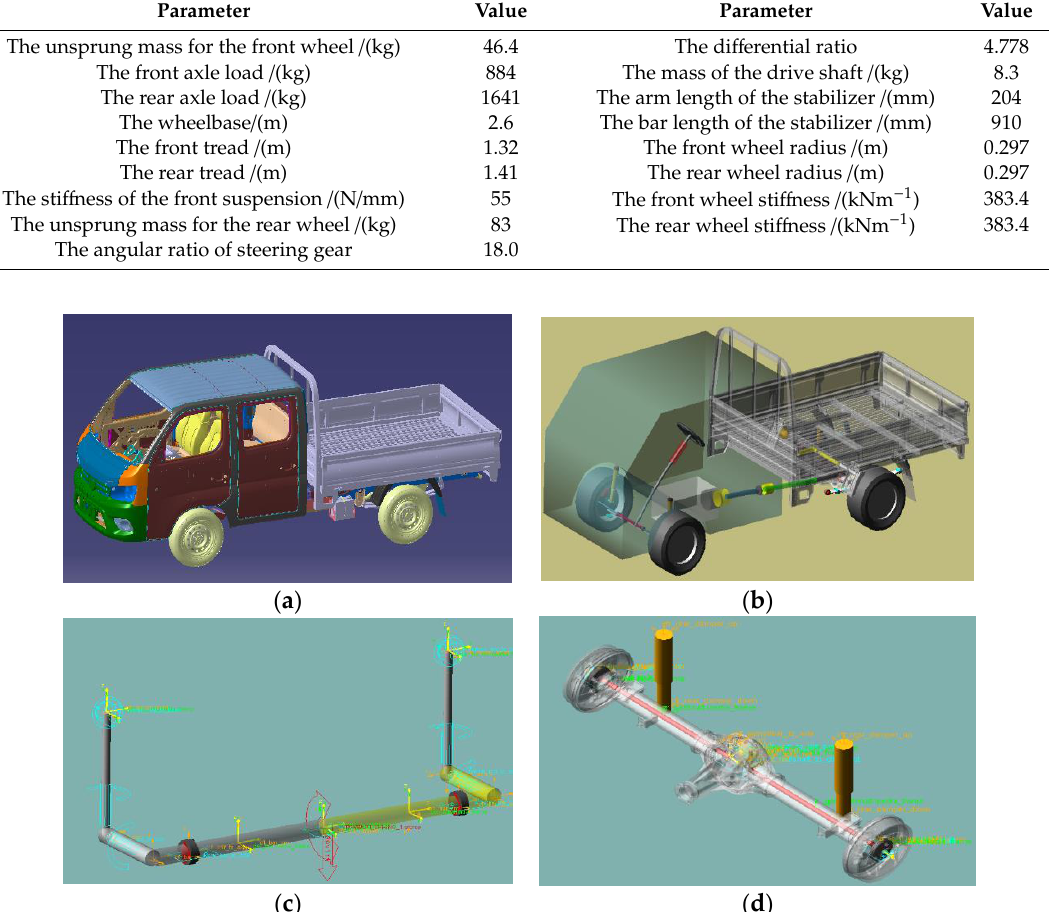
Table 3. The parameters values of the light truck.